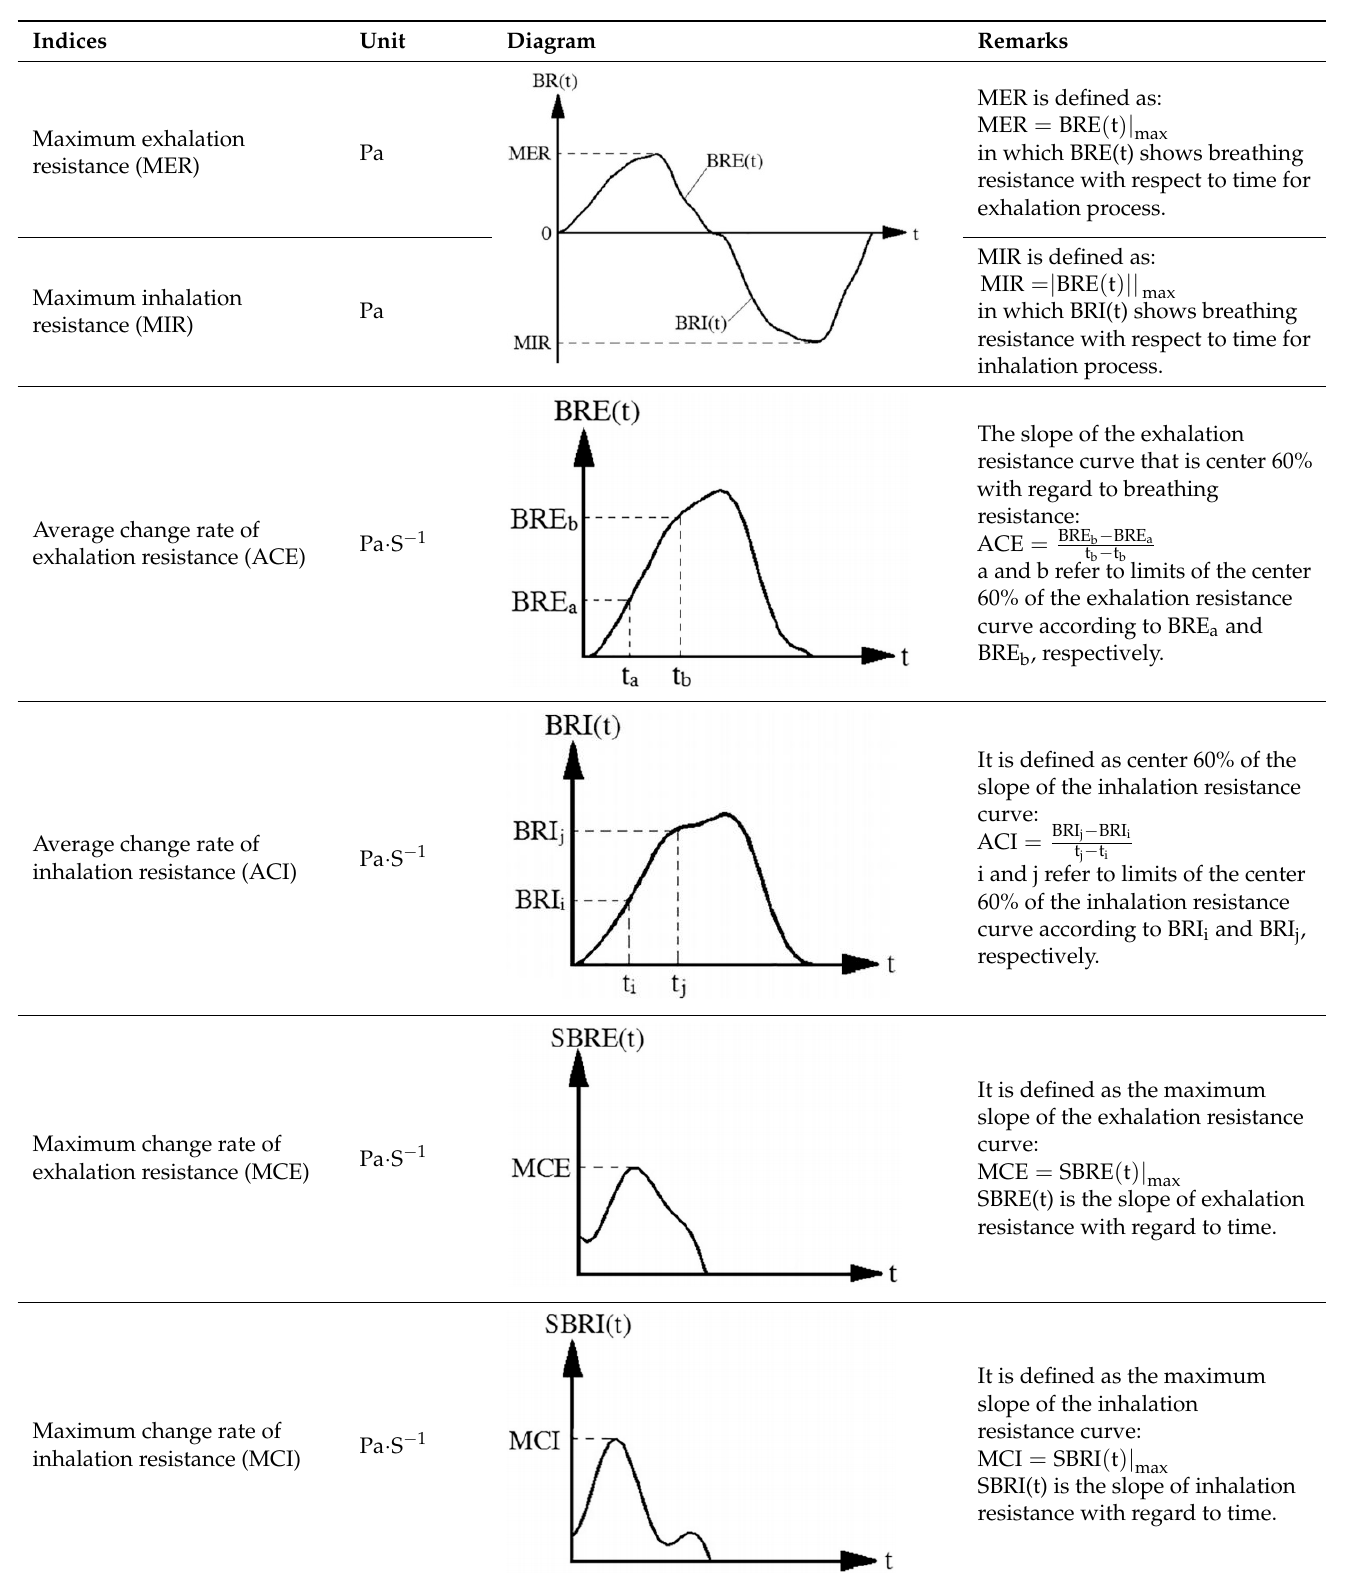
Table 8. The six indices presented for DBR measurement [63].